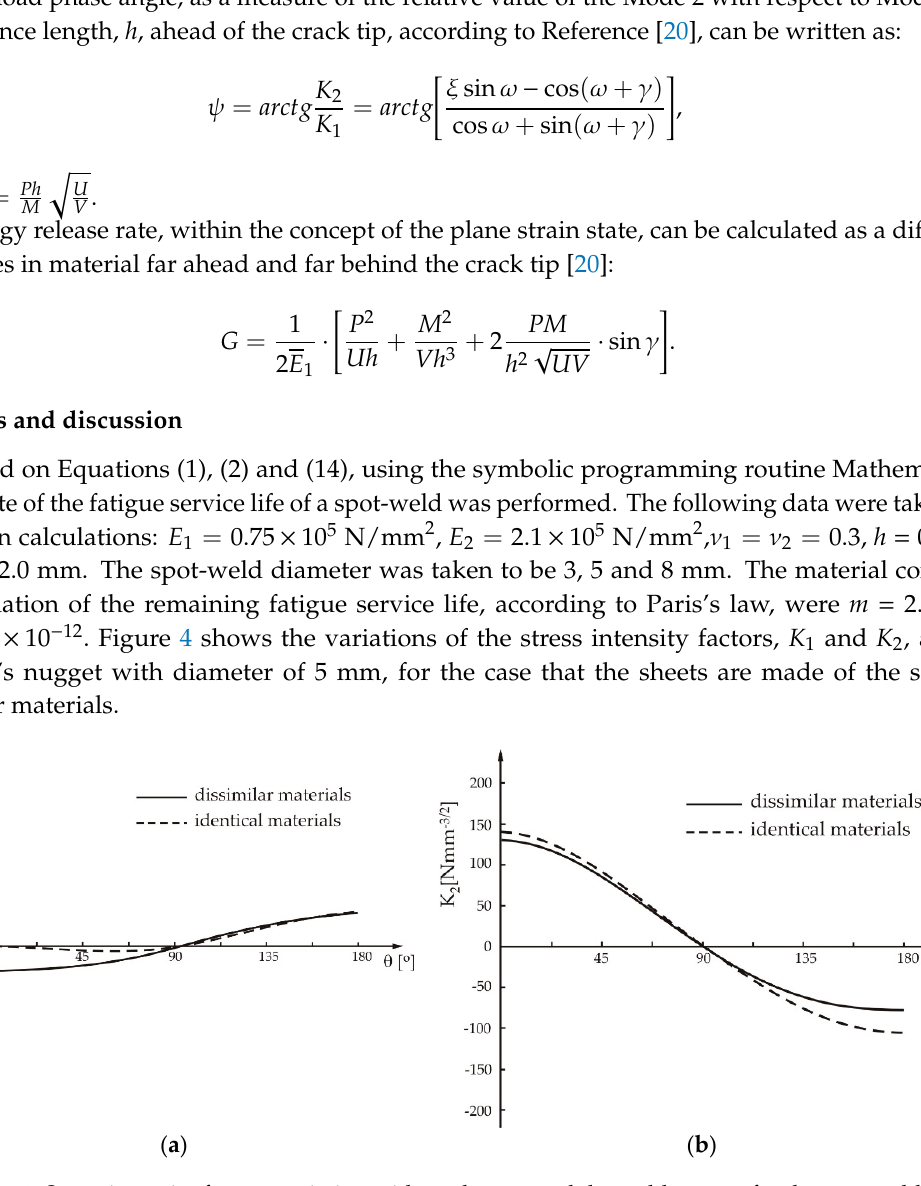
Figure 4. Stress intensity factors variation with angle q around the weld nugget for the spot weld of identical and dissimilar materials: ( a ) K 1 and ( b ) K 2 . identical and dissimilar materials: ( a ) K 1 and ( b ) K 2